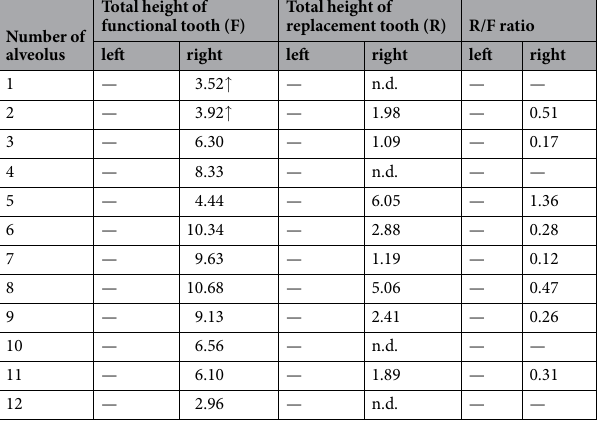
Table 7. Tooth height and the R/F ratio in the lower jaw of CAGS-IG-VD-002. n.d. = not developed. ↑ = the true size should be higher for the crown was lost. All measurements in